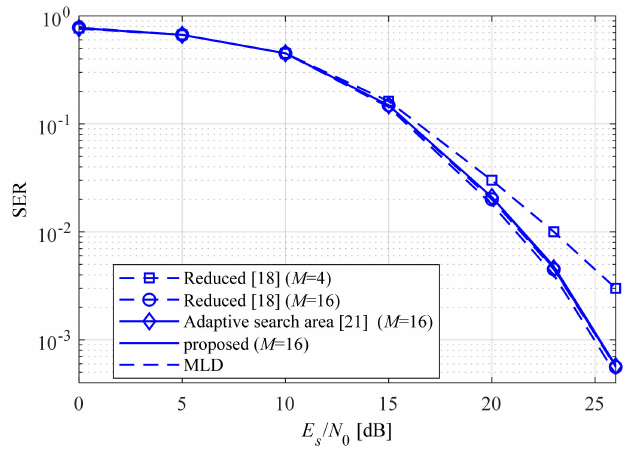
Figure 8. Symbol error rate (SER) performance comparisons for N = L = 3 with 16 QAM. MLD, maximum likelihood